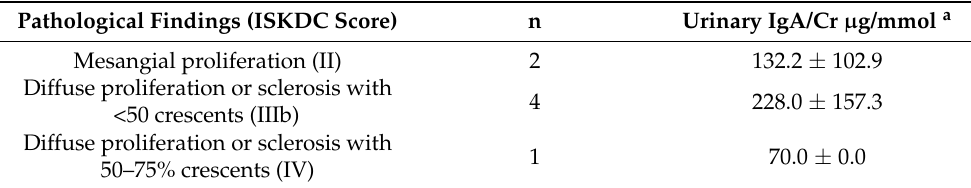
Figure 1. Urinary IgA/Cr concentrations between patients with IgAV compared to HC ( a ); between patients with IgAVN, IgAVwoN, and HC ( b ) with mean lines. Asterisks indicate a statistically significant difference between the groups (* p < 0.05, ** p < 0.01, *** p < 0.001). Results are normalised to urinary creatinine (Cr). Table 2. Descriptive table of urinary IgA/Cr concentrations in biopsy-proven IgAVN patients classified as per the histological